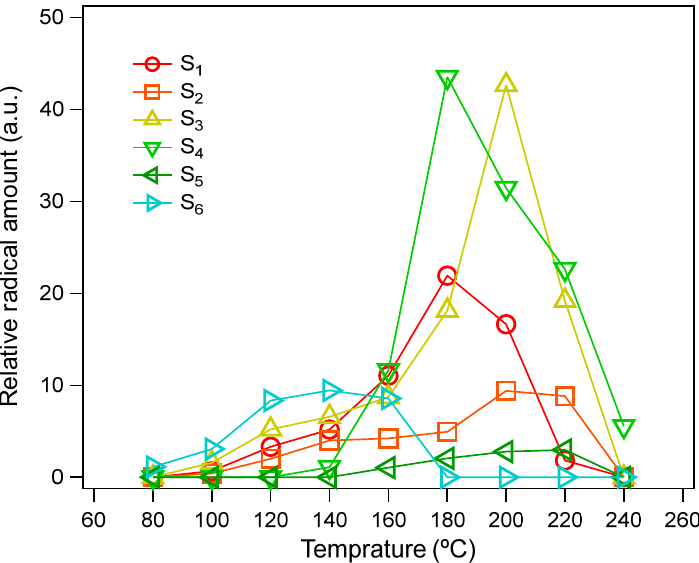
Figure 6. Radical amounts of spin adduct produced during stepwise heating of the PA66 sample. For the production of the secondary amine radical in the thermal degradation of polyamide, two mechanisms have been proposed for temperatures higher than 300 °C, which is much higher than the temperature conditions in our case: either main chain scission producing ● NH − and ● CH 2 − , or hydrogen abstraction from the β -methylene group to the NH group producing ● NH − and − ● CH − [17], as shown in Scheme 2. It has been reported that the bond dissociation energy on the bond NH − CH 2 is lowest in the PA66 molecular structure [35]; this leads to the assumption that main chain scission at − NH − CH 2 − is more likely in decomposition. Indeed, we observed a large amount of S 1 derived from ● CH 2 − , as shown in Figure 6. In the case of the β -scission scheme, the main chain radical − ● CH − is produced, which may be trapped and observed as the S 2 spin adduct. However, in our study, we could not detect a spin adduct derived from the amino radical ● NH − ; this may be due to the high reactivity of the amino radical ● NH − and low reactivity of TTBNB against a nitrogen radical. Scheme 2. The secondary amide generation scheme for the thermal degradation mechanism of PA66.